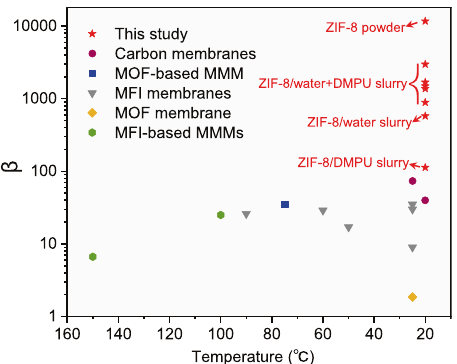
Fig.5|SeparationperformanceofZIF-8powderandZIF-8slurriescomparedto top-performing materials. Comparison of the n-butane/isobutane separation factor ( β ) of ZIF-8 powder and ZIF-8 slurries with various membranes reported in literatures. (Carbon memabranes 5,53 ; MOF-based mixed matrix membrane 15 ; MFI